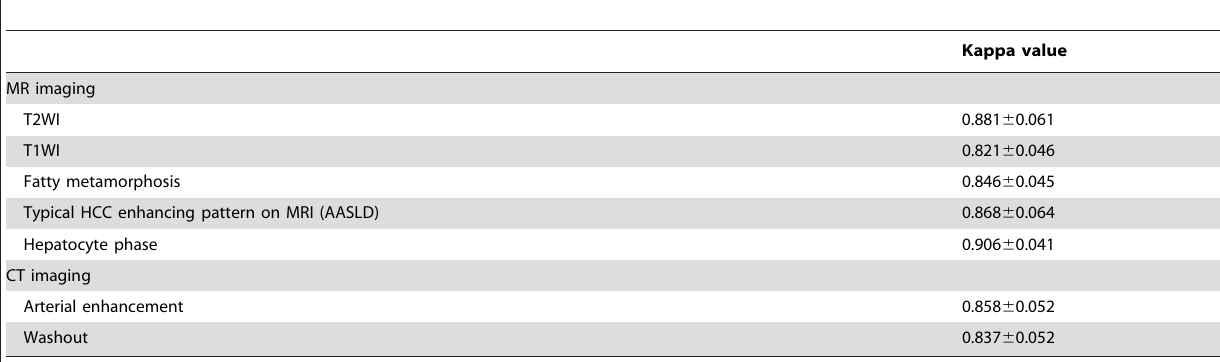
Table 2. The inter-observer difference for the study nodules on CT and MR imaging.